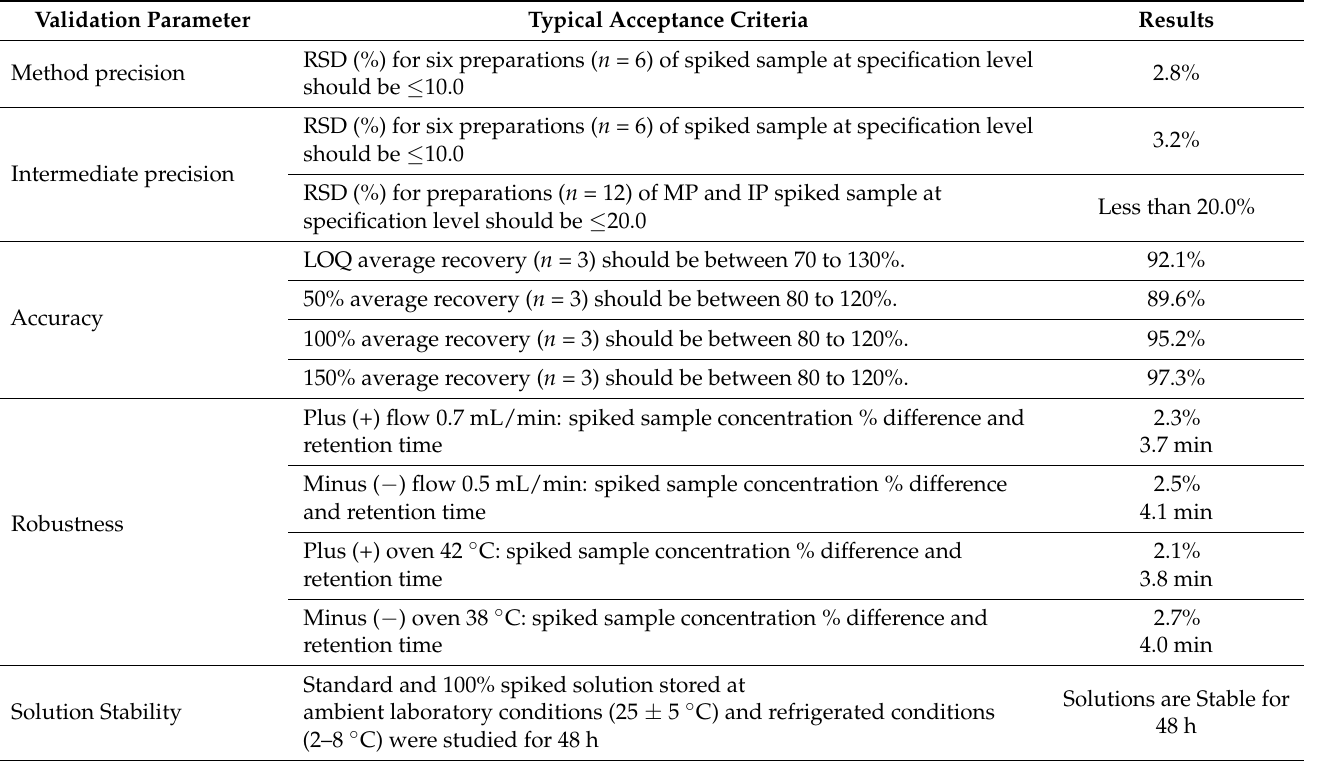
Figure 5. MS/MS MRM chromatogram of linearity solutions. Table 3. Summary of method validation